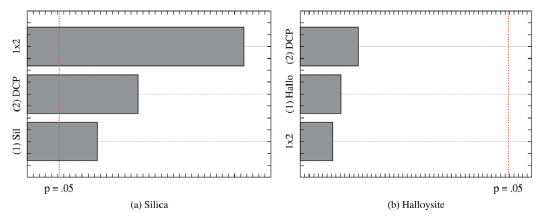
Figure 5. Pareto diagrams: Effect of varying concentrations of DCP and amount of filler on the response variable storage modulus. (a) Silica, and (b) Halloysite.